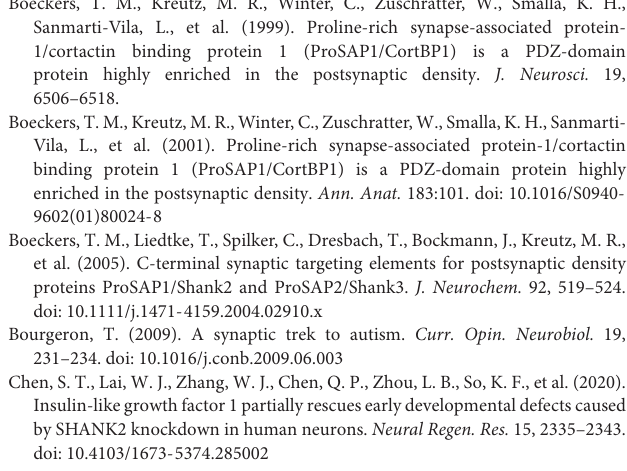
Supplementary Figure 1 | Characterization of hiPSC lines. (A) A scheme of hiPSC reprogramming. (B) Pluripotency staining for SOX2, OCT4, NANOG, TRA-1-81, TRA-1-60, and SSEA4. Scale bar = 50 µ m. (C) Expression of pluripotency genes KLF4, SOX2, OCT4, and NANOG. Mean ± SEM. (D) Germline